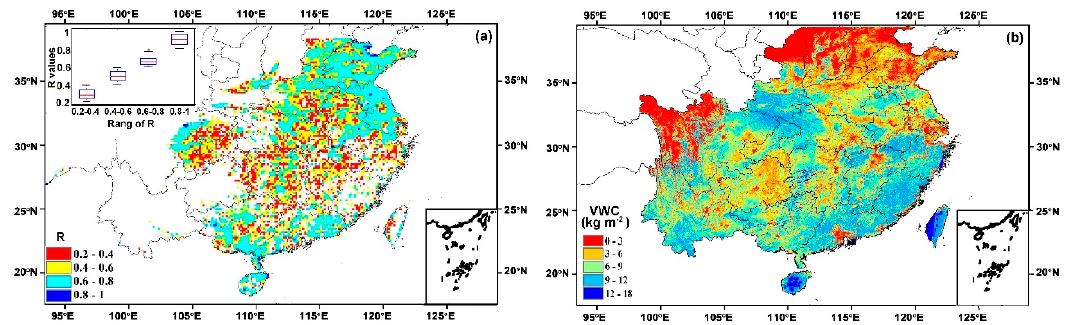
Figure 3. ( a ) Distribution of TDS-1 P r,eff in May 2017; ( b ) distribution of CYGNSS SR in May 2017.